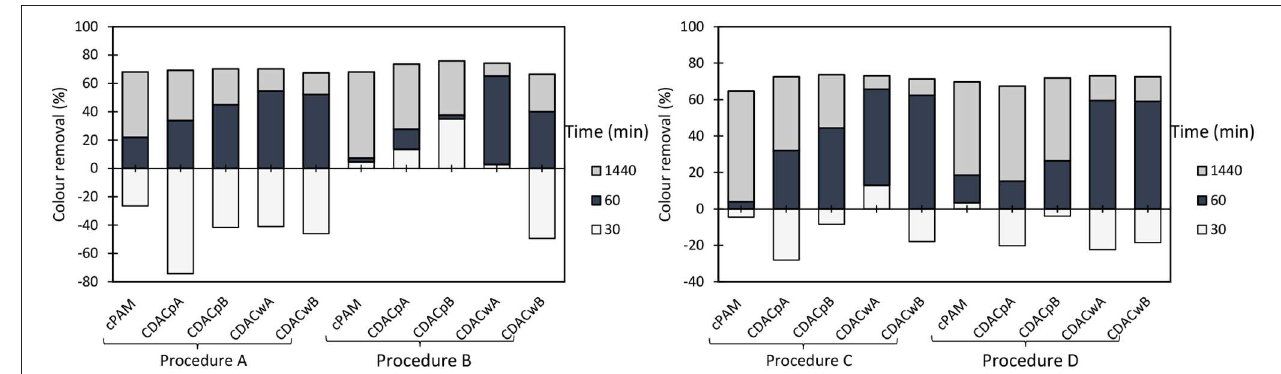
FIGURE 5 | Turbidity removal of industrial effluent as a function of time of settling, using cationic cellulose-based flocculation agents from bleached pulp (CDAC p A and B) and from wood chips (CDAC w A and B), in a dual system with bentonite, at pH 7.0. Procedure A: 0.3 wt% bentonite followed by 2.67 mg/L of flocculant. Procedure B: 0.6 wt% bentonite and 5.34 mg/L of flocculant. Procedure C: 0.3 wt% bentonite and 5.34 mg/L of flocculant. Procedure D: 0.6 wt% bentonite and 2.67 mg/L of flocculant. A cationic synthetic cPAM (in dual system with the same concentrations described in procedures A–D), was used as reference.